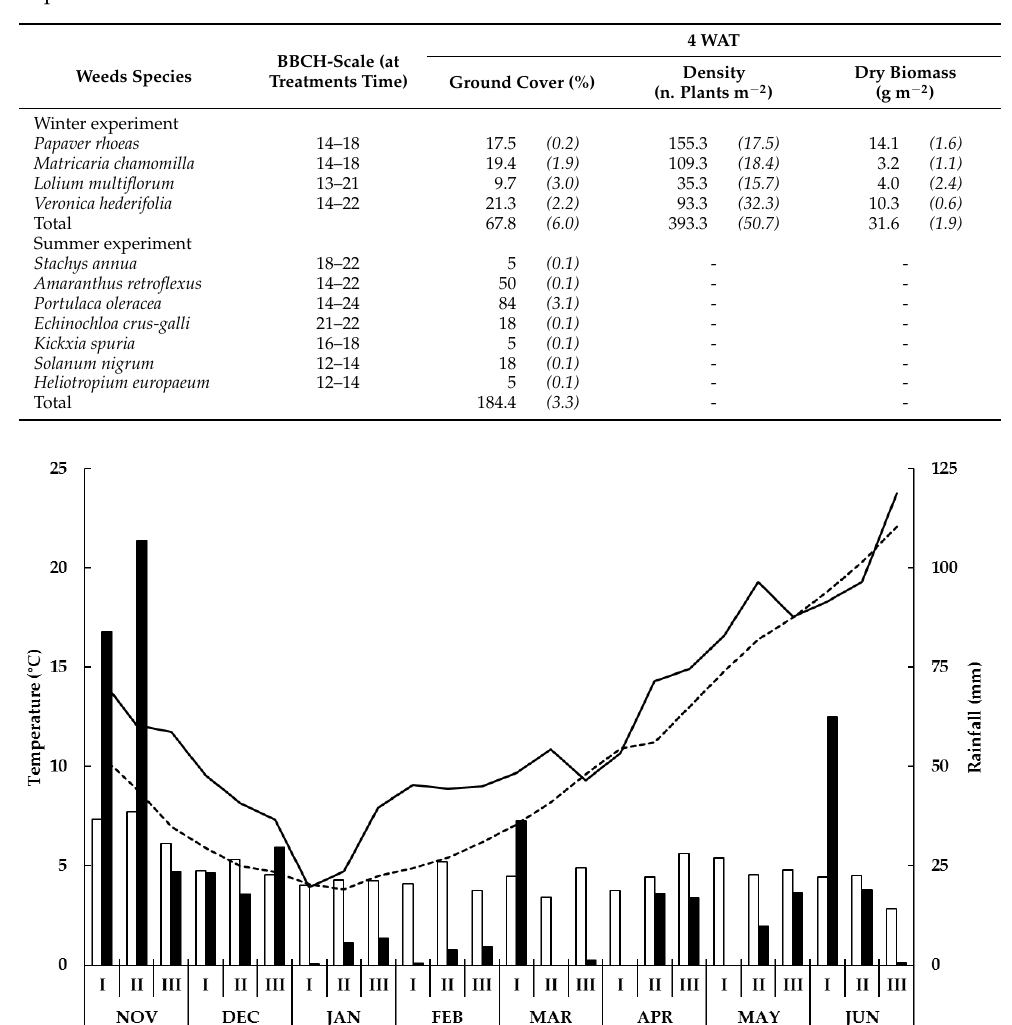
Table 1. Weed species in the untreated control of the two experiments: BBCH growth stages at treatments time and weed parameters evaluated 4 weeks after treatments (WAT). Standard errors are in parentheses.